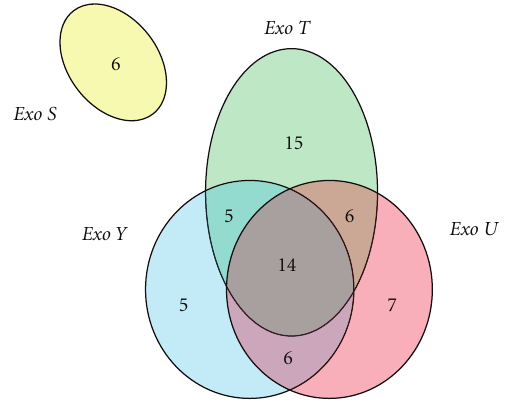
Figure 3: Distribution of exoenzyme genes detected by PCR in P. aeruginosa isolates in this